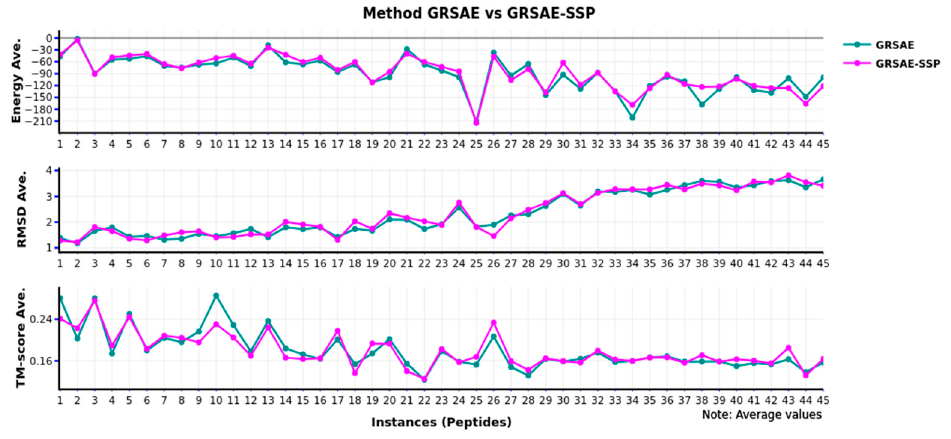
Figure 4. Comparison of GRSAE versus GRSAE-SSP.